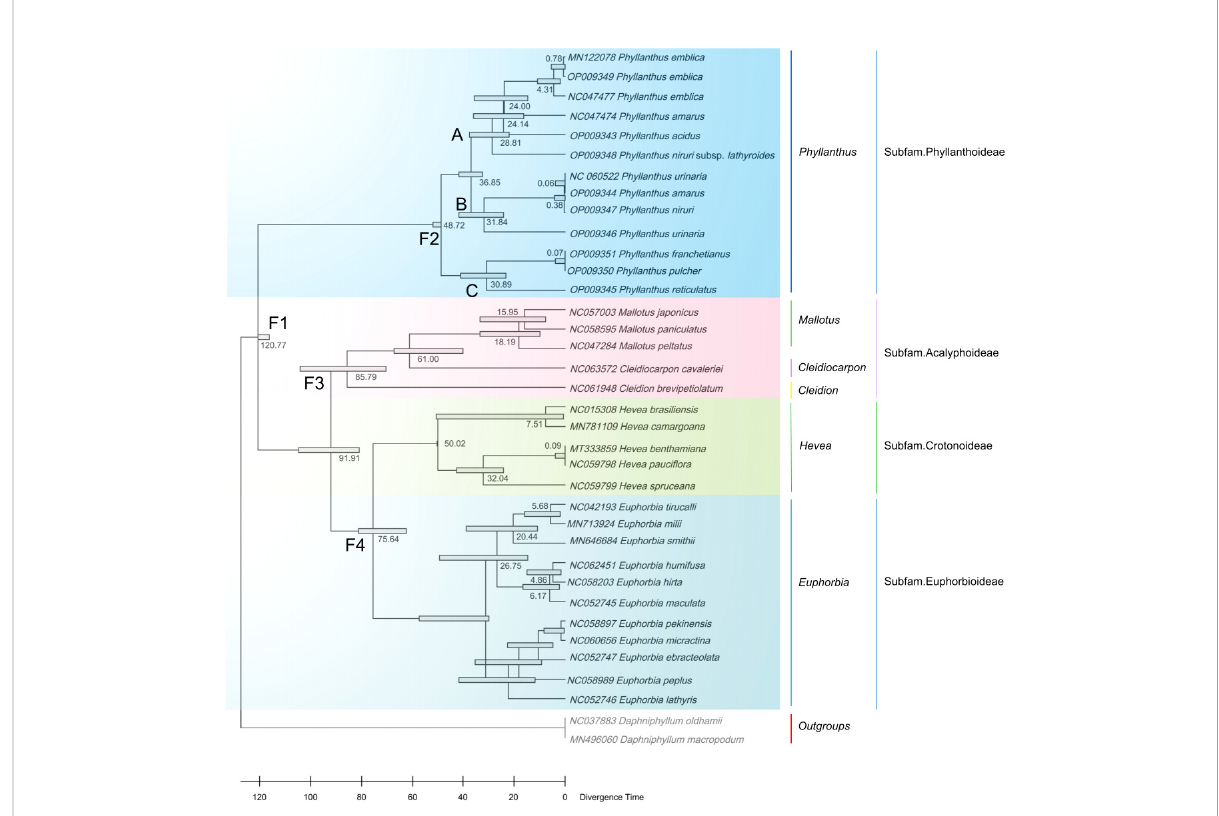
FIGURE 6 Divergence times estimation based on cp genomes. The node ages are given for each